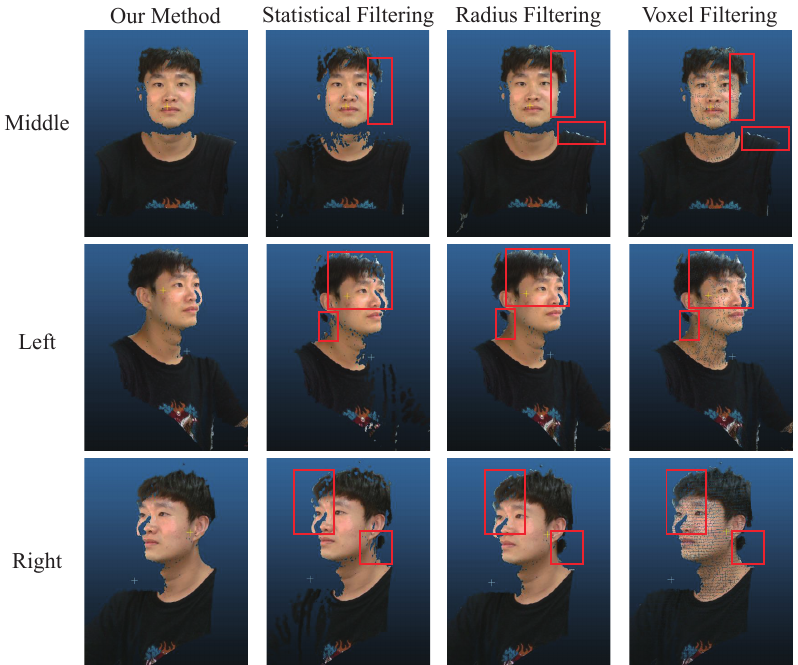
Figure 6. Comparison of point cloud filtering results under different camera views. The red box contains the noise that the other filtering method failed to filter out.